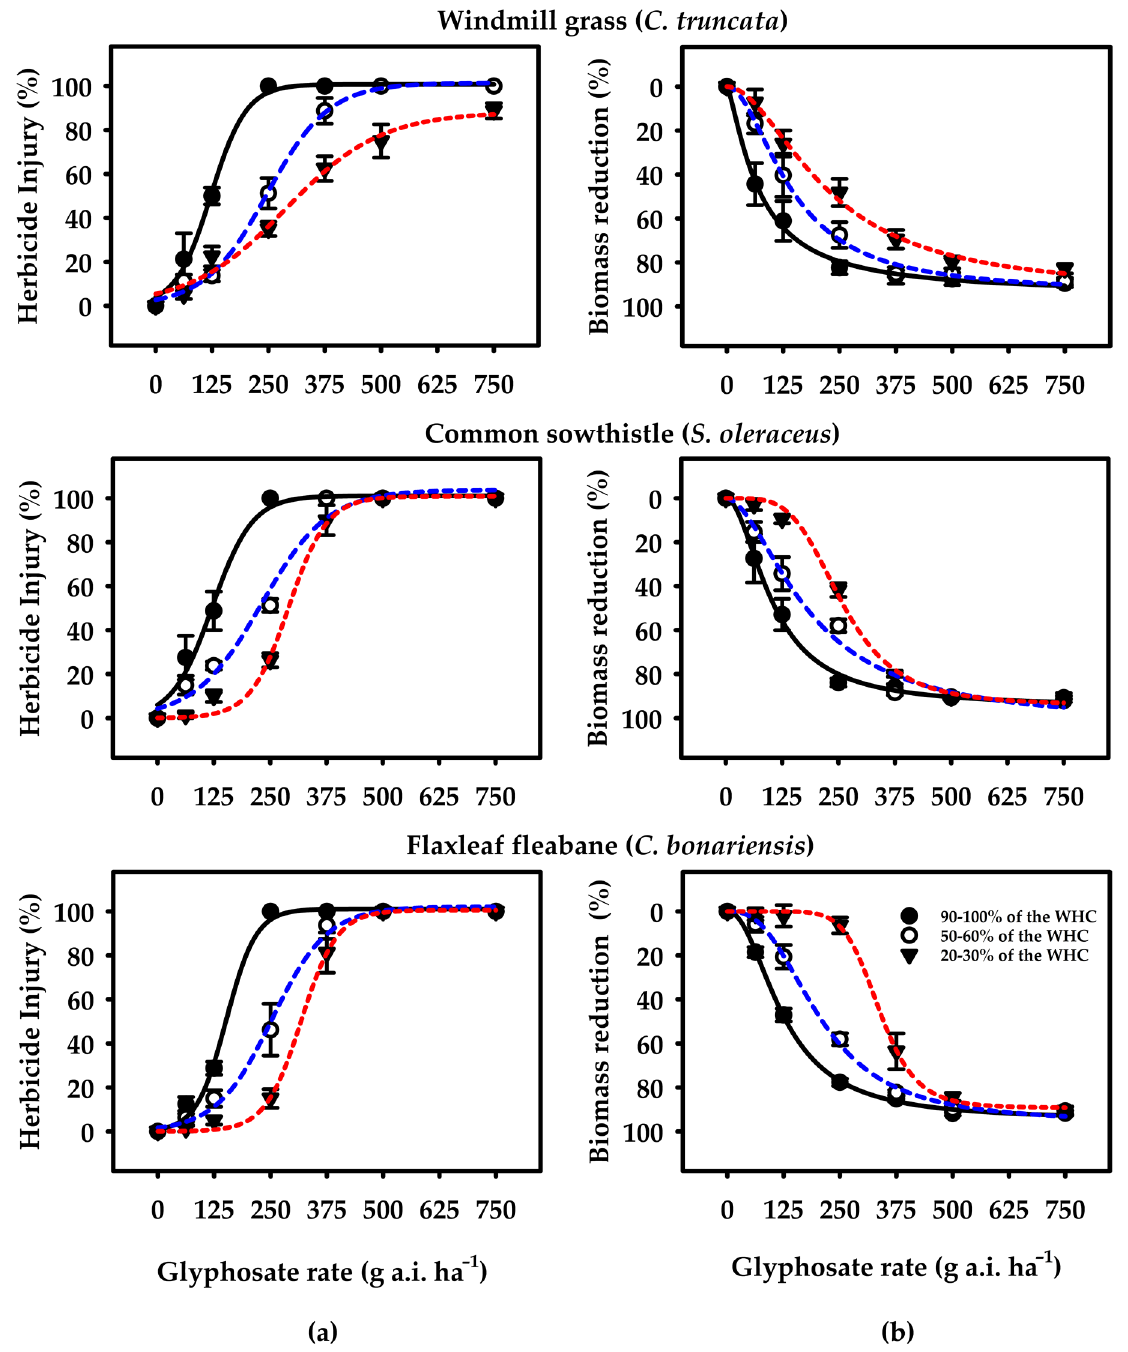
Figure 2. Herbicide control ( a ) and dry biomass reduction ( b ) of C. truncata , S. oleraceus , and C. bonariensis as a function of glyphosate rates (0, 63, 125, 250, 375, 500, and 750 g a.i. ha − 1 ) and soil moisture regimes [( ) 90–100% of the WHC = high soil moisture availability (HSM), ( ) 50–60% of the WHC = moderate soil moisture availability (MSM), and ( ) 20–30% of the WHC = reduced soil moisture availability (RSM)] at 21 days after spraying. The figures show the observed data fitted to Equations (1) and (2). Error bars represent the ± two standard errors of the mean (n = 8) from repeated experiments. The results showed that higher LD 50 values (316.7 g a.i. ha − 1 ) of glyphosate was re- quired to cause 50% injury to C. truncata under RSM in comparison to other soil water contents; glyphosate at 122.2 and 244.5 g a.i. ha − 1 caused 50% injury under HSM and MSM,